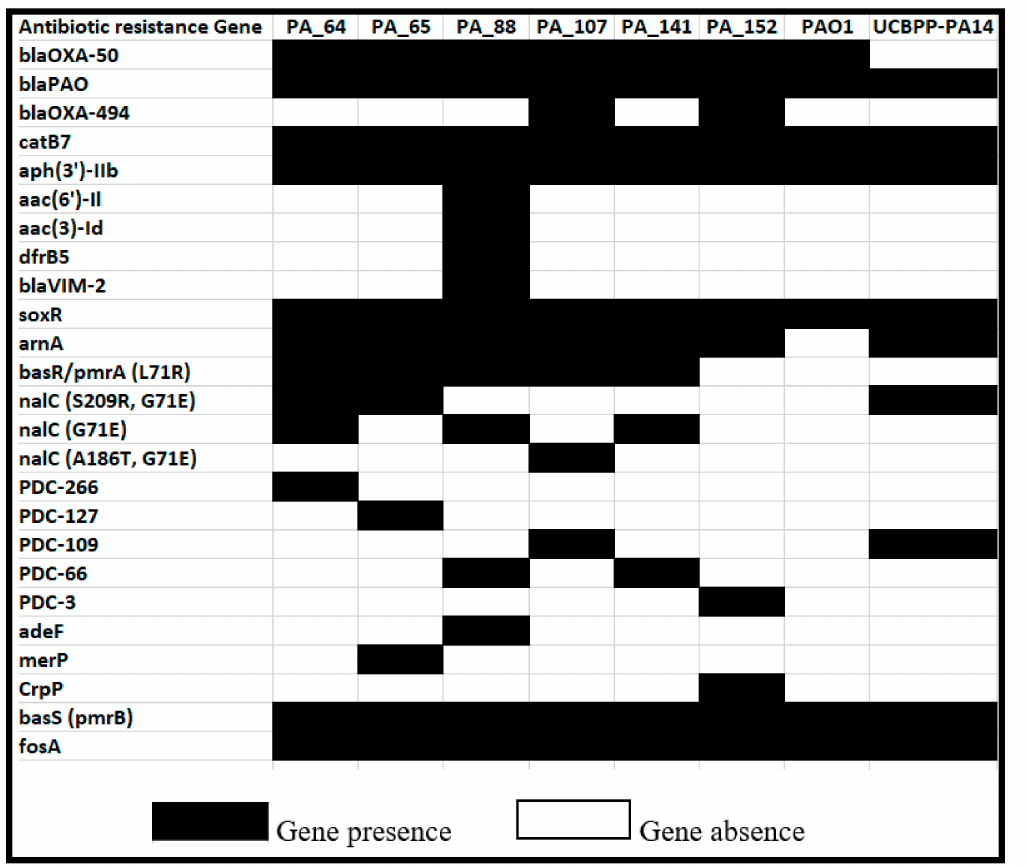
Figure 1. The presence and absence of antimicrobial resistance genes and antibiotic resistance-associated mutations detected in P. aeruginosa clinical strains compared to the reference strains PAO1 and